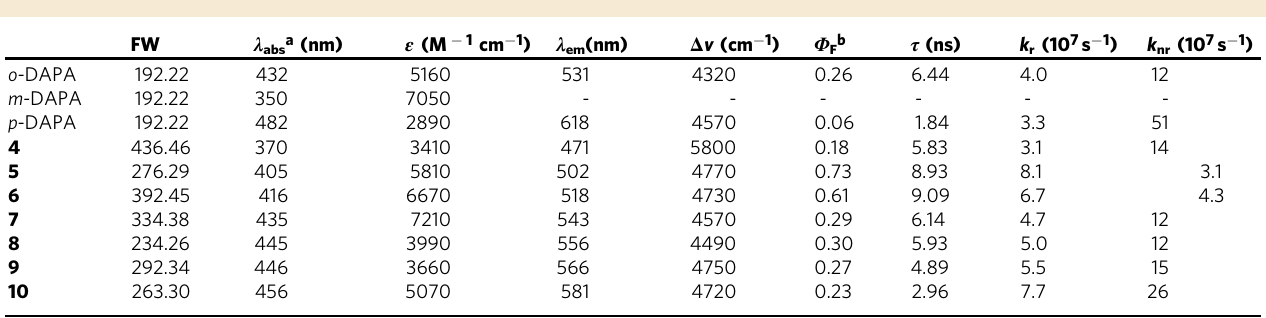
Fig. 4 Full-color fl uorophore library of DAPA. a Chemical structures of p -DAPA derivatives 4 – 11 , along with capped-stick representation of 5 generated with crystallographically determined atomic coordinates. Hydrogen bonds are denoted by dotted lines. b Fluorescence images of 4 – 10 and p -DAPA in CHCl 3 under irradiation of 365nm UV light (top), and normalized emission spectra (bottom). c Chromaticity coordinates (CIE) of 4 – 10 and p -DAPA in CHCl 3 . Table 1 Photophysical properties of o -DAPA, m -DAPA, p -DAPA, and 4 –